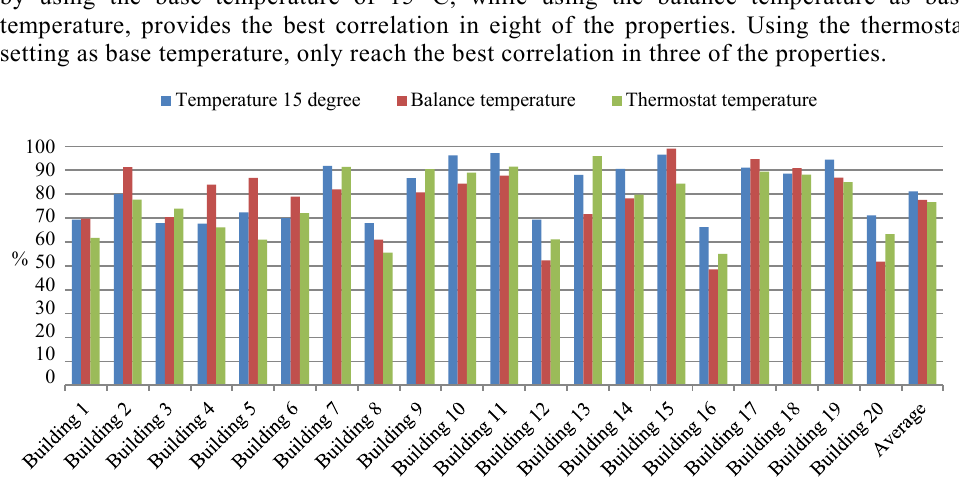
Fig. 3. Coefficient of determination for all buildings and each base